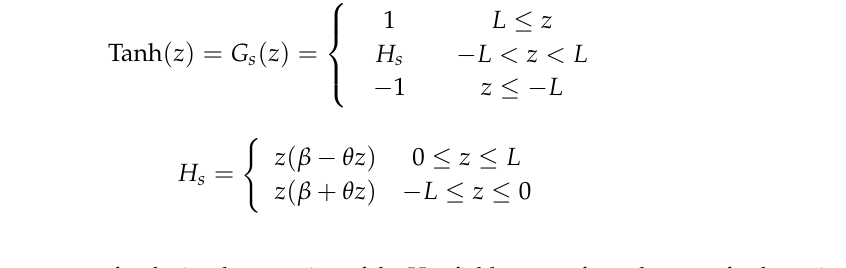
Table 6. FPGA resources for the implementation of the Hopfield neuron from the sets of values given in Table